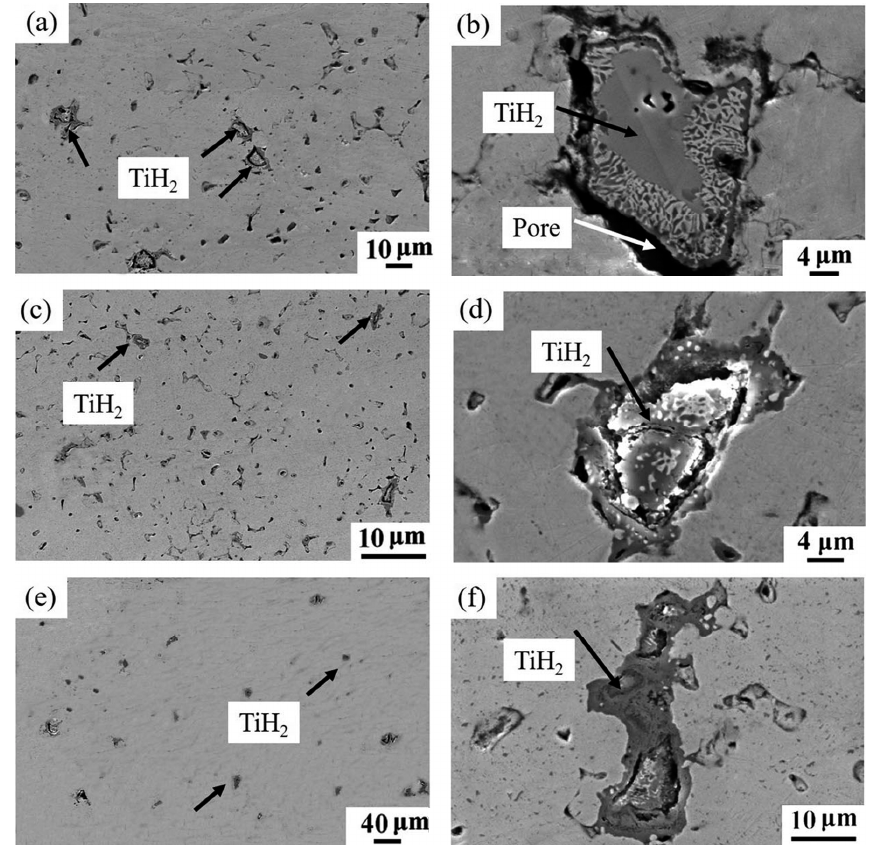
Figure 7. SEM micrographs of Cu-0.5 wt.% TiH 2 samples sintered at 950 °C ( a ) without isothermal treatment; ( c ) isothermally treated at 650 °C for 0.5 h, ( e ) isothermally treated at 650 °C for 1 h, ( b ), ( d ) and ( f ) are higher magnification of the figures show in (a,c,e), respectively.